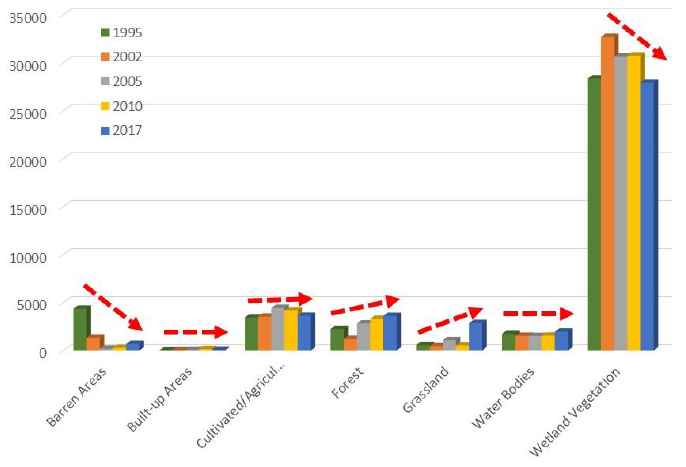
Figure 8. Overall trend of land-cover changes within the Agusan Marsh Wildlife Sanctuary, a protected area. (Figure 10). The average simulated inundation depth all over the marsh was highest at 1.21 m in 2017, and lowest in 2010 at 0.90